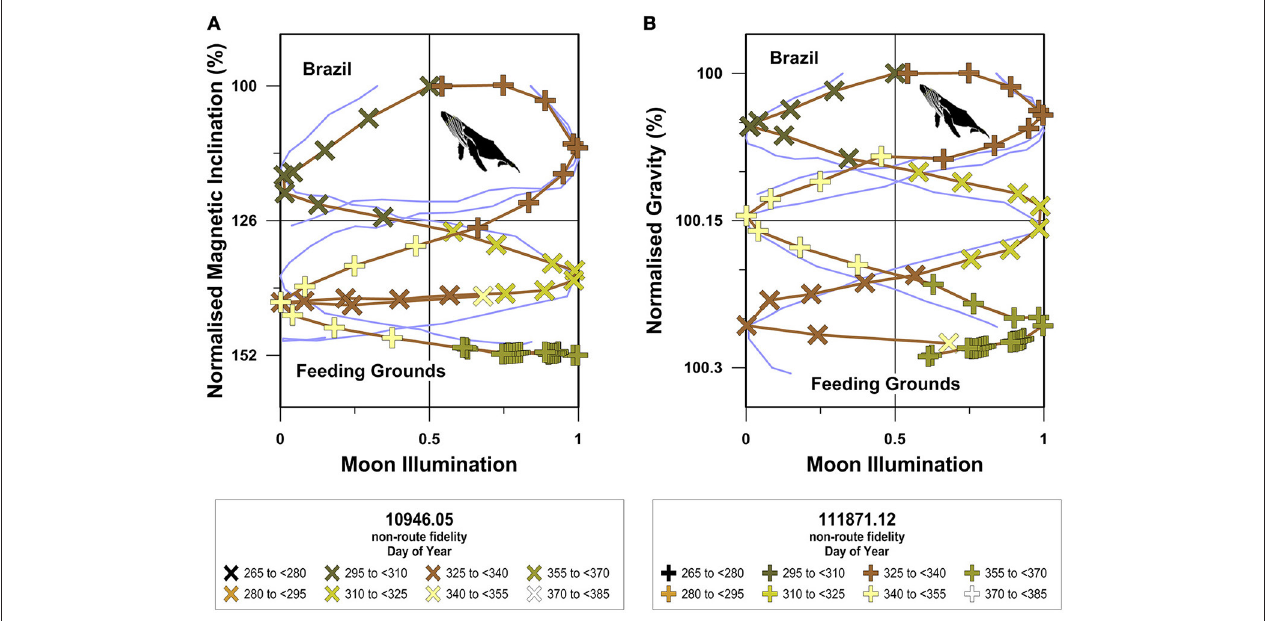
FIGURE 8 | Site-normalized South Atlantic humpback whale magnetic inclination and gravitational trajectories. In this figure geocentric magnetic inclination and latitude and bedrock dependent g L + g B values have been normalized to the values present at the locations inhabited immediately prior to the onset of long-distance open-ocean migration at the individual level. Site-normalized magnetic inclination (A) and gravitational acceleration (B) values are displayed as percentages and are plotted against the moon illumination cycle as in Figures 5 – 7 . Route fidelity movements are shown as light blue lines and non-route fidelity movements are symbolized as indicated in the figure legends. Non-route fidelity track symbol colors correspond with day of the year and exceed 365 days when the tracked movement spanned Julian calendar years.